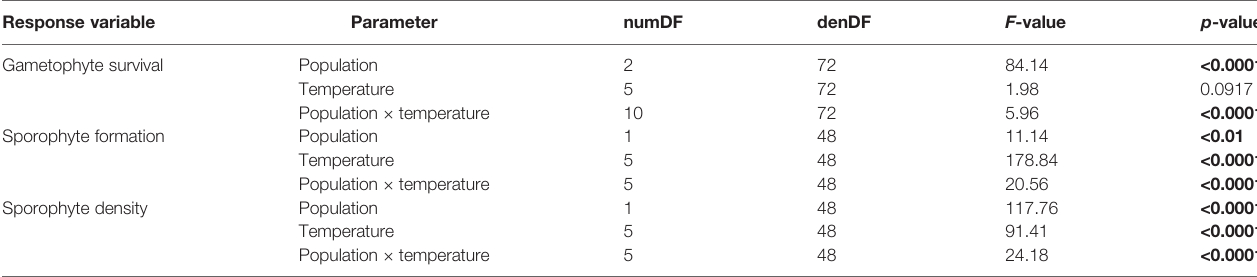
TABLE 3 | Results of two-way ANOVAs to examine the effects of temperature and population on the response variables gametophyte survival, sporophyte formation and sporophyte density of Laminaria digitata from Spitsbergen, Tromsø and Quiberon on day 21 along the lower temperature gradient (0-15°C) in experiment 2. Response